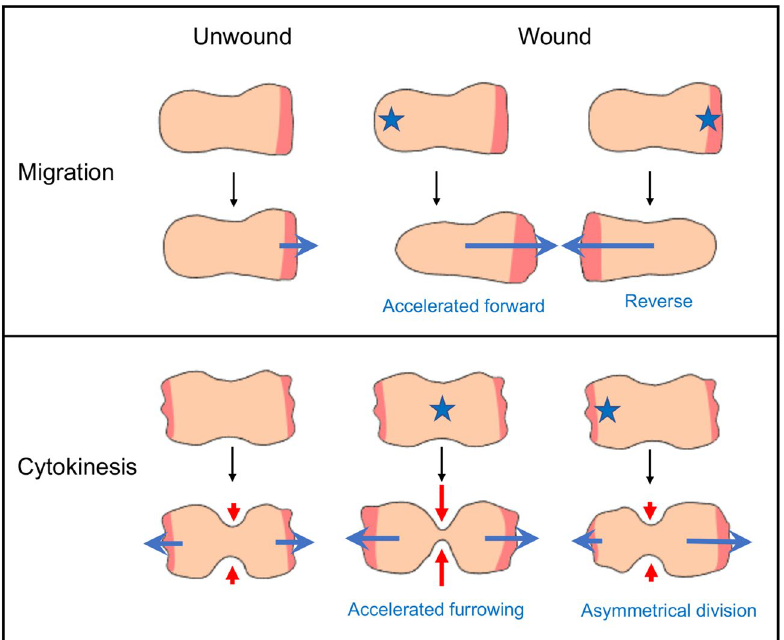
Figure 4. Summary of the behaviors of migrating and dividing cells upon wounding. When the posterior region of migrating cells is wounded, the cell migrates forward with an increased speed. When the anterior region of migrating cells is wounded, the cell migrates in opposite directions. When the furrow of dividing cells is wounded, the cell divides with an increased furrowing. When the daughter half of the dividing cells is wounded, the cell asymmetrically divides. Anterior and polar pseudopods are shown in red, wounds are shown by asterisks, the directions of cell movement are shown by blue arrows, and the directions of furrowing are shown by red